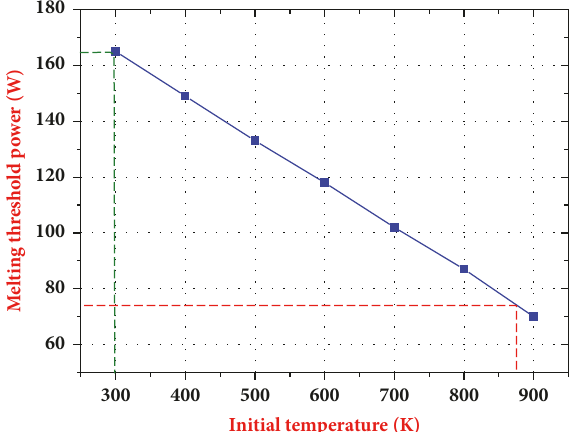
Figure 4: The melting threshold power of Ge under different initial